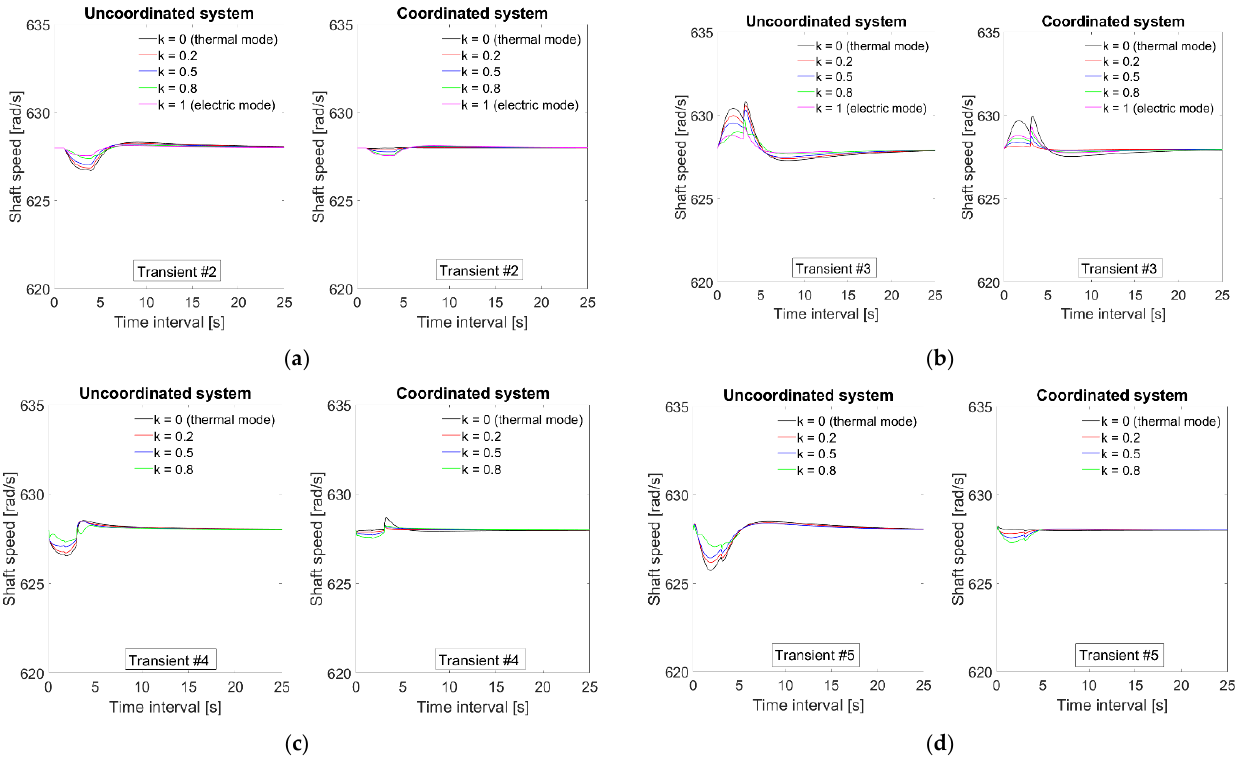
Figure 8. Effect of power split k on LP spool speed, with and without the coordination block: ( a ) Transient #2, ( b ) Transient #3, ( c ) Transient #4, and ( d ) Transient #5. Figure 9 underlines the effect of coordination on each transition previously defined.